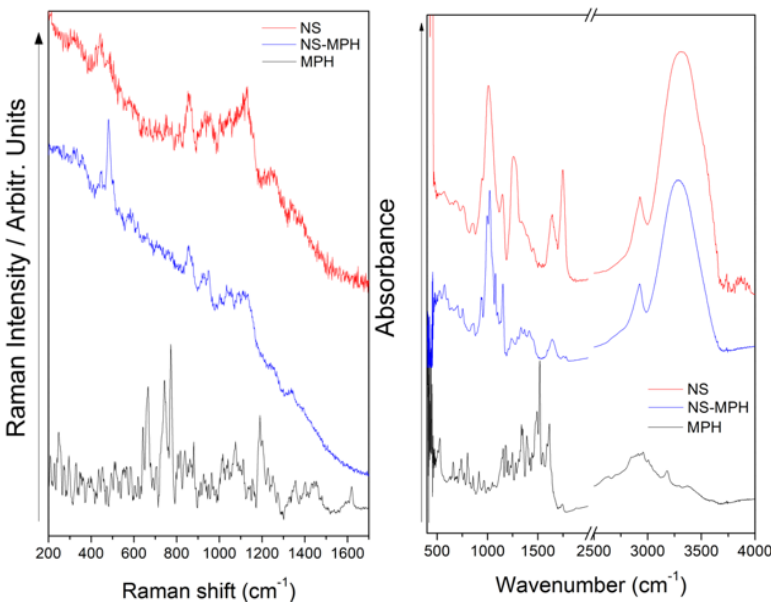
12 of 29 Figure 8. Raman ( left ) and FT-IR spectra ( right ) of NSs, CUR and NSs–CUR. Finally, the Raman and FT-IR profiles of the NSs–MPH system offered us information about the interaction of the species. The Raman spectrum (see Figure 9) displays two